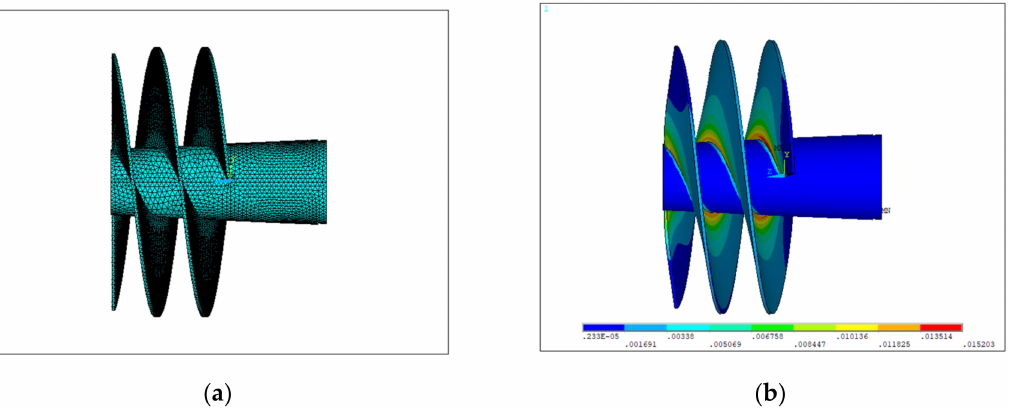
Figure 10. The inducer model in a front view: ( a ) finite element model; ( b ) Simulation results of von Mises